Question: In a single sentence, describe what this figure presents.
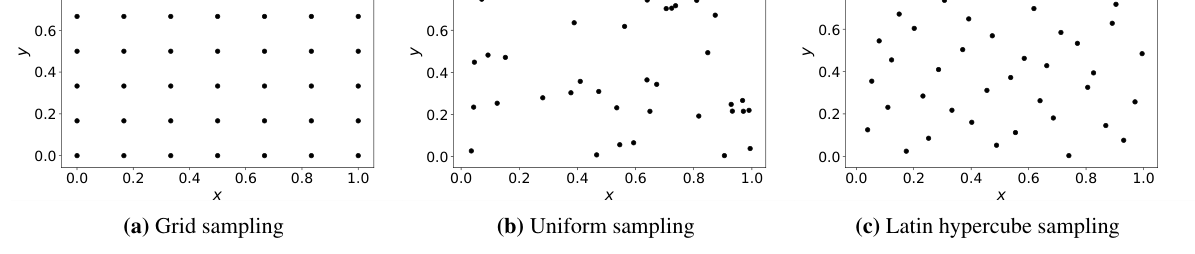
Answer: – Different one-shot sampling strategies. (a) Grid sampling. The input domain is discretized using equidistant samples. (b) Uniform sampling. The sample points are generated from a uniform distribution in the input domain. (c) Latin hypercube sampling. The points are sampled such that there is only one point at each section of a divided input space.